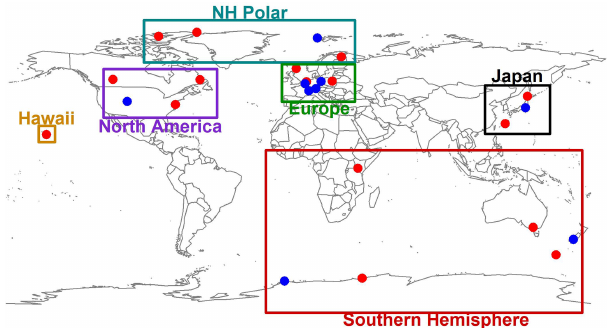
Figure 1. Map showing ozonesonde locations. Locations with data spanning 1990–2017 are shown in red, and locations with data ex- tending to the 1980s are shown in blue. The boxes represent the regions into which all ozonesondes are